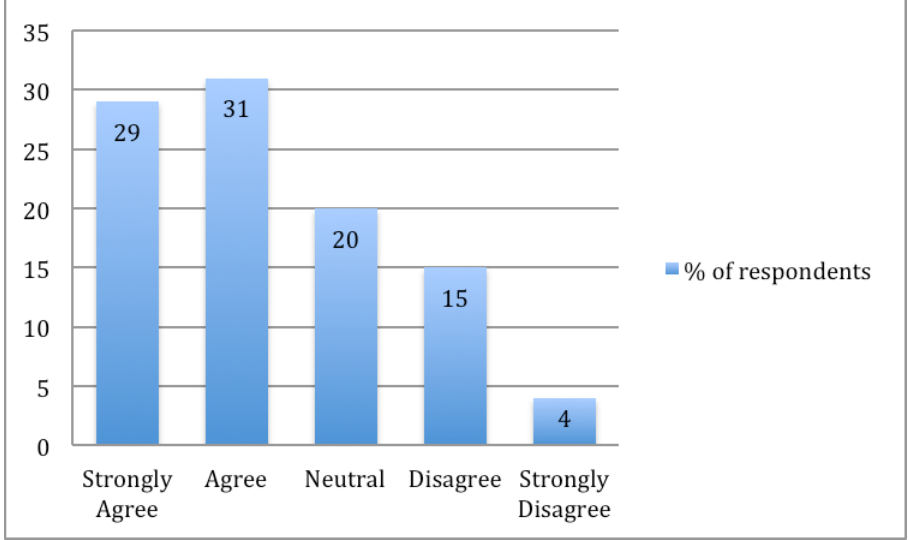
Figure 2. Lack of policies at institutional